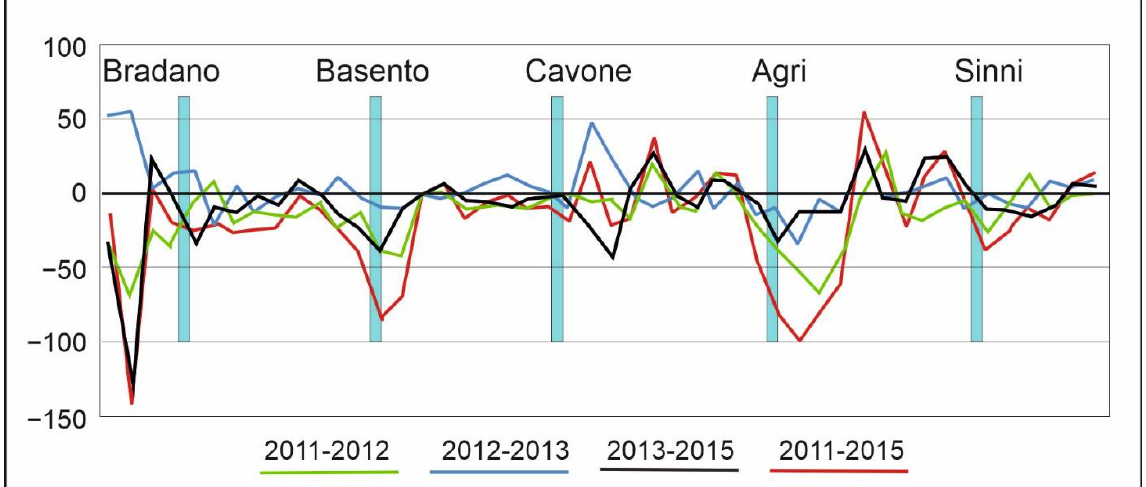
Figure 3. Recent shoreline evolution (river names are reported and their positions are outlined in blue).